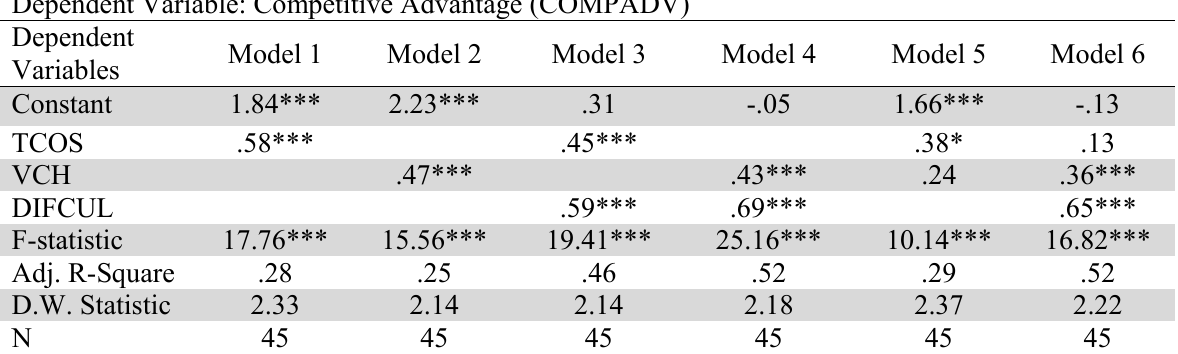
Results of the estimated